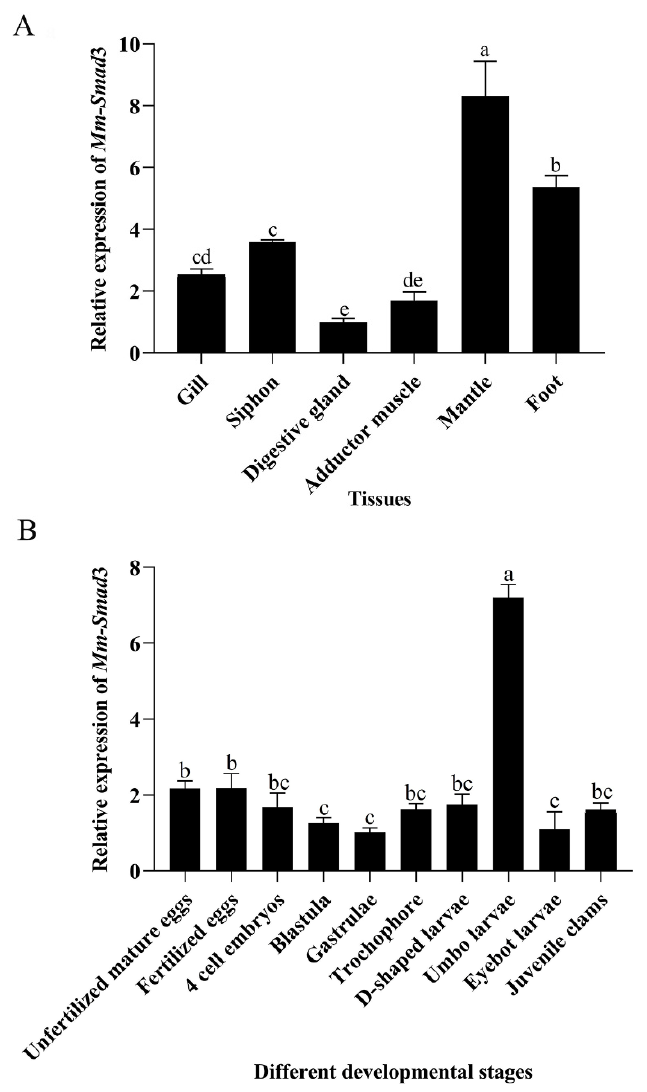
Figure 4. Quantitative expression analysis of Mm-Smad3 in M. meretrix . ( A ). Expression profile of Mm-Smad 3 in different tissues. ( B ). Expression profile of Mm-Smad 3 in different developmental stages. Different letters on the columns represent statistically significant differences at p < 0.05.